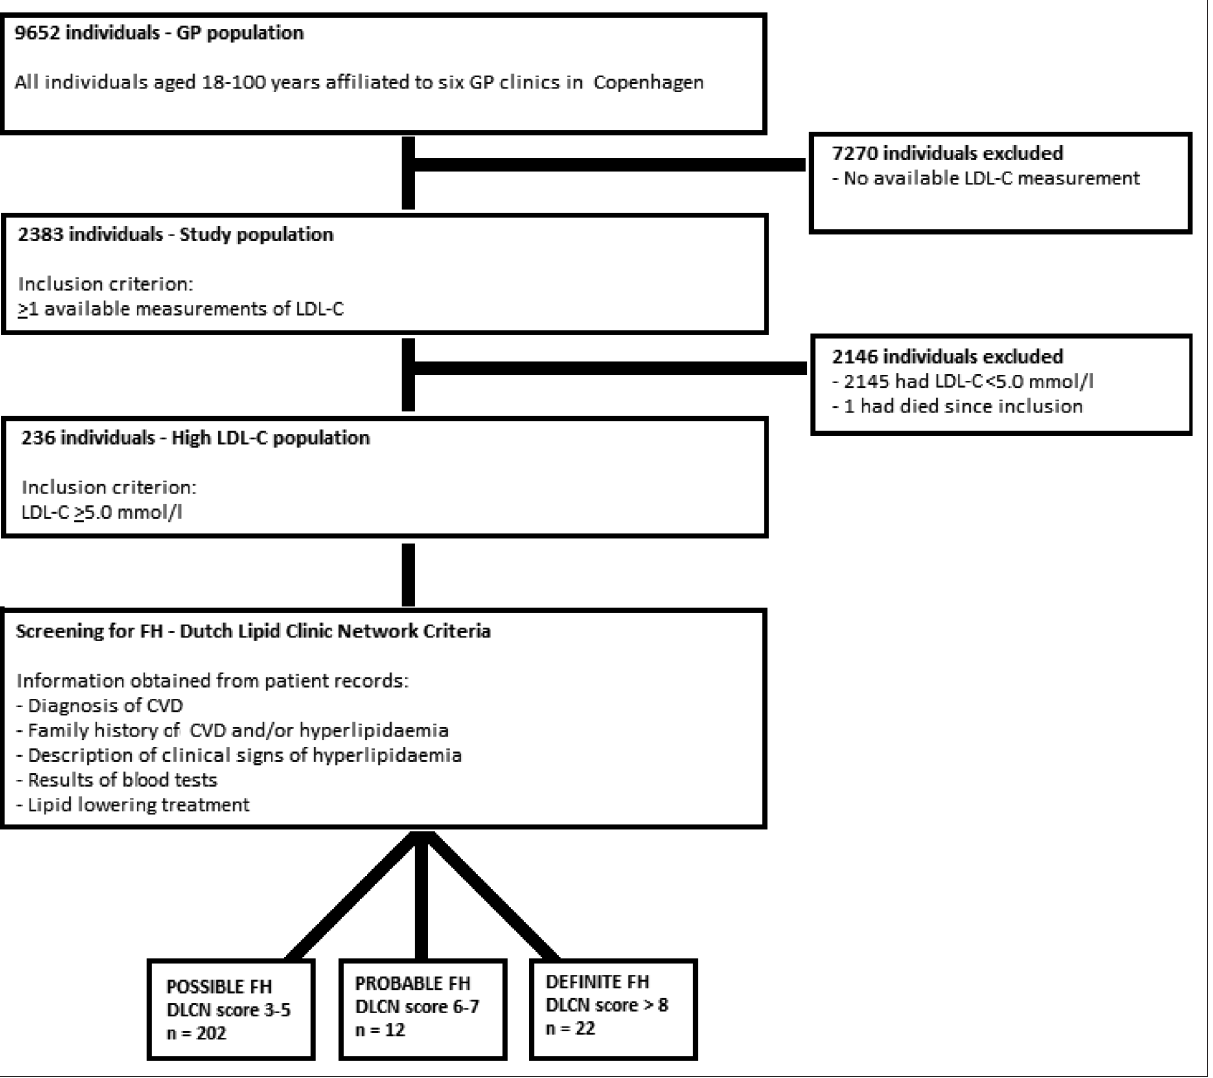
Figure 1 Flowchart of inclusion and exclusion throughout the study. The study population consisted of all patients with ≥1 available LDL- C measurements. The high LDL- C population ( n = 236 individuals) consisted of patients with ≥1 LDL- C reported ≥5.0 mmol/l. CVD = cardiovascular disease. DLCN = Dutch Lipid Clinic Network. FH = familial hypercholesterolaemia. LDL- C = low- density lipoprotein